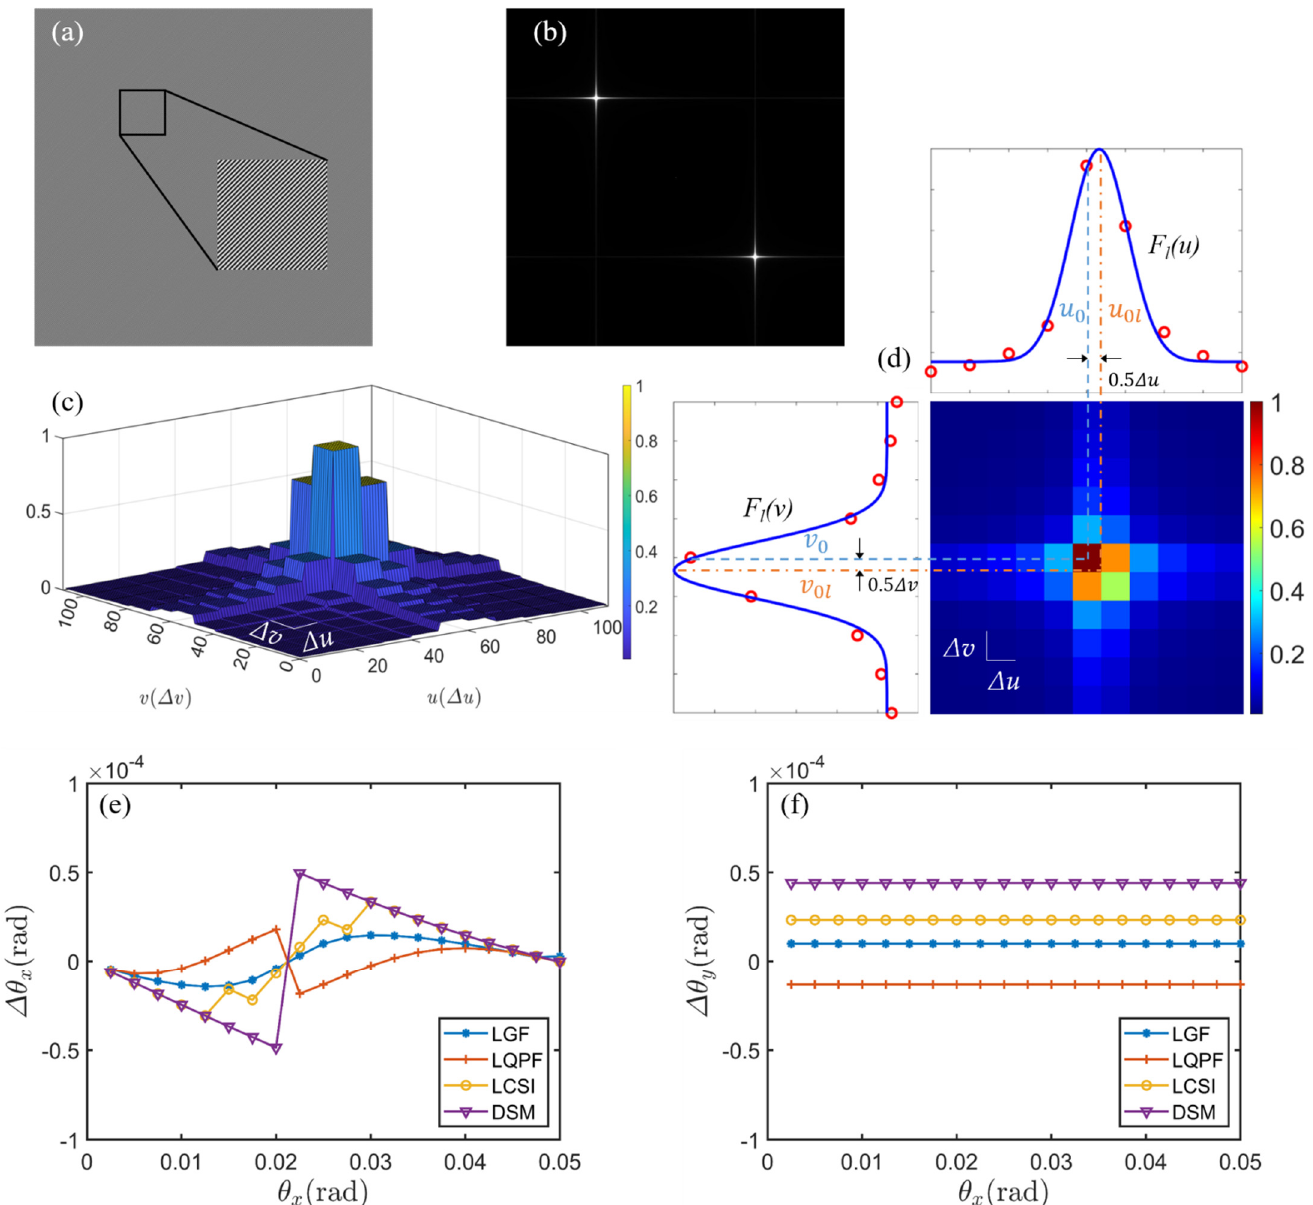
Figure 3. Analysis of one frequency peak on spatial spectrum plane and comparison of the result from LGF with that from other RTA evaluation methods ( a ) interference fringe by two plane waves ( b ) one frequency spectrum distribution on SSP ( c ) three-D frequency spectrum distribution and ( d ) error source for the location of one frequency peak center, ( e ) ∆ θ x and ( f ) ∆ θ y distributions from four methods when θ y = 0.025